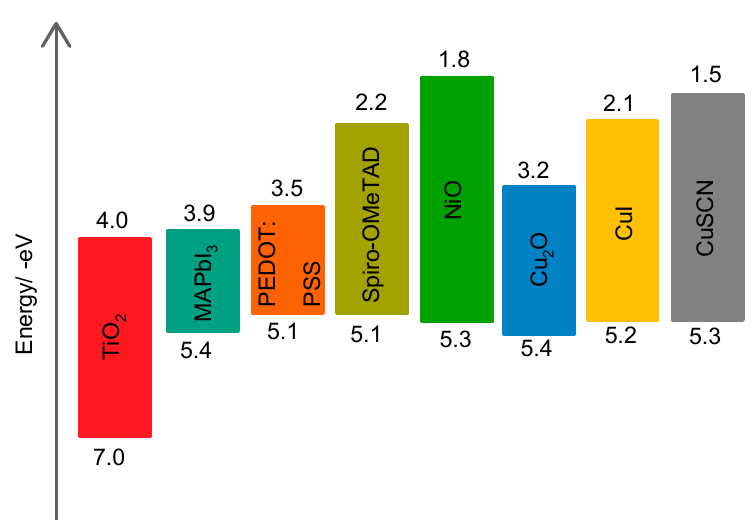
Figure 2. Schematic of the energy levels of CuSCN, perovskite material, TiO 2 ETM and various HTMs [34,35].